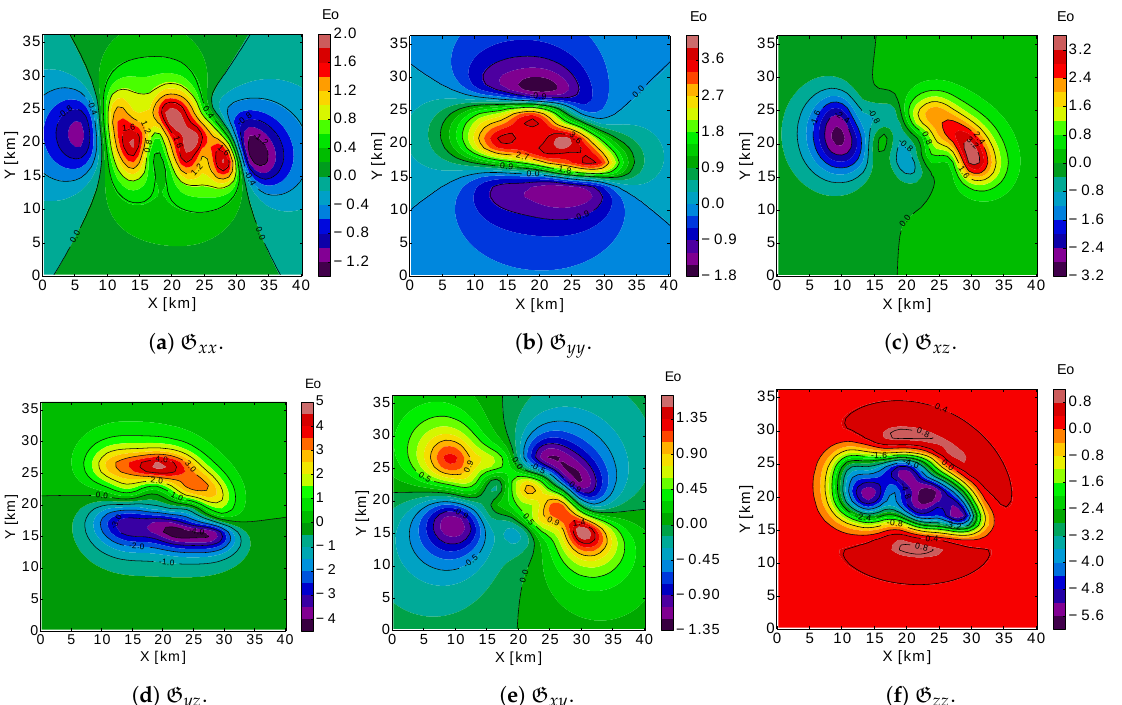
Figure 11. Isolated salt body (removed regional field) gradiometric response for the real data-based